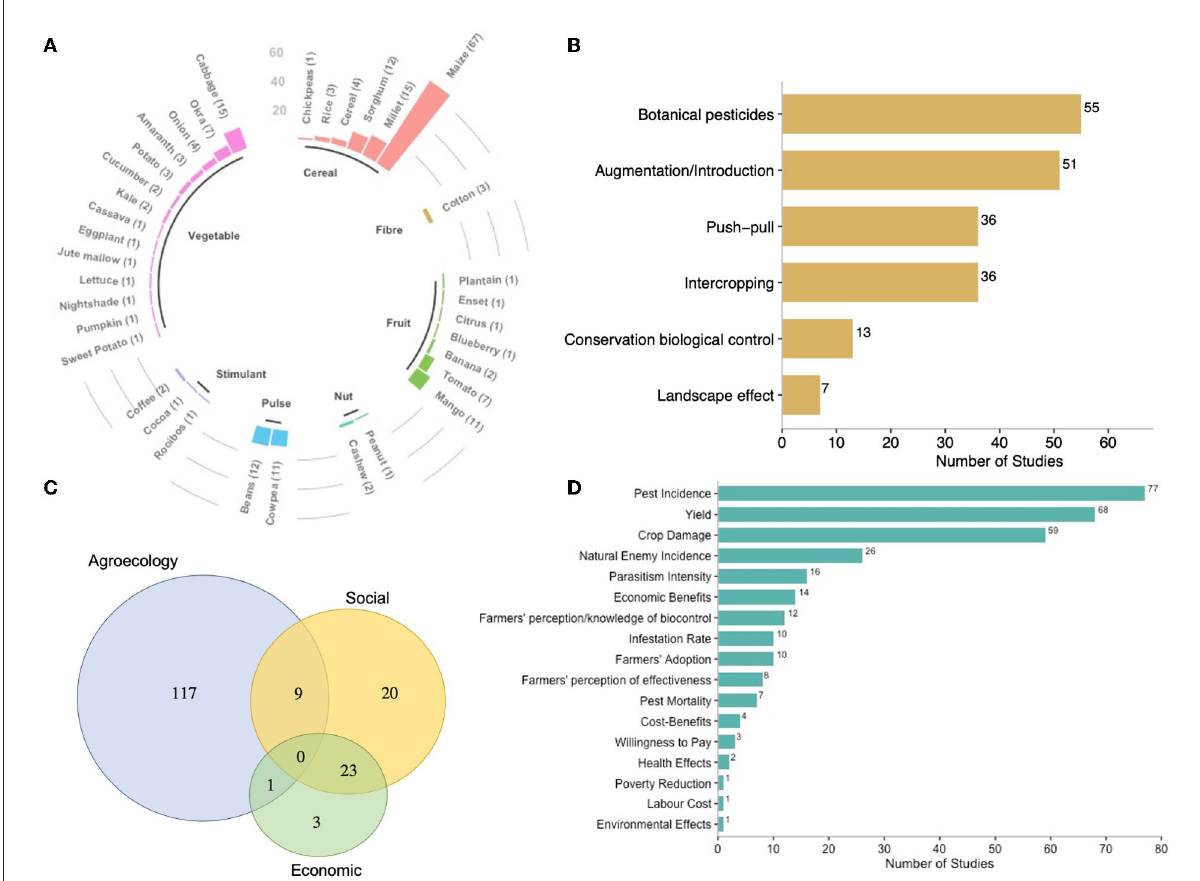
FIGURE3 Overview of the 173 studies on biocontrol intervention in SAA. Number of studies by (A) crop type, (B) biocontrol intervention, (C) discipline, and (D) measure of outcome. The total number of studies is at the end of each column. The overall number exceeds 139 as some studies evaluated more than one biocontrol intervention, in more than one country and/or more target pests. Note that “Conservation biological control” refers to studies that examined those biocontrol practices as a broad umbrella of interventions. “Landscape effect” refers to studies that explored the effect of distance to natural habitat and/or landscape complexity on the delivery of biocontrol ecosystem services to the